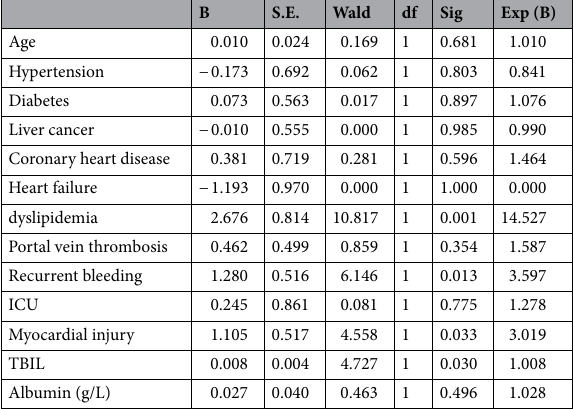
Table 2. Multivariable analysis for 6-week mortality in cirrhosis associated EGVB.